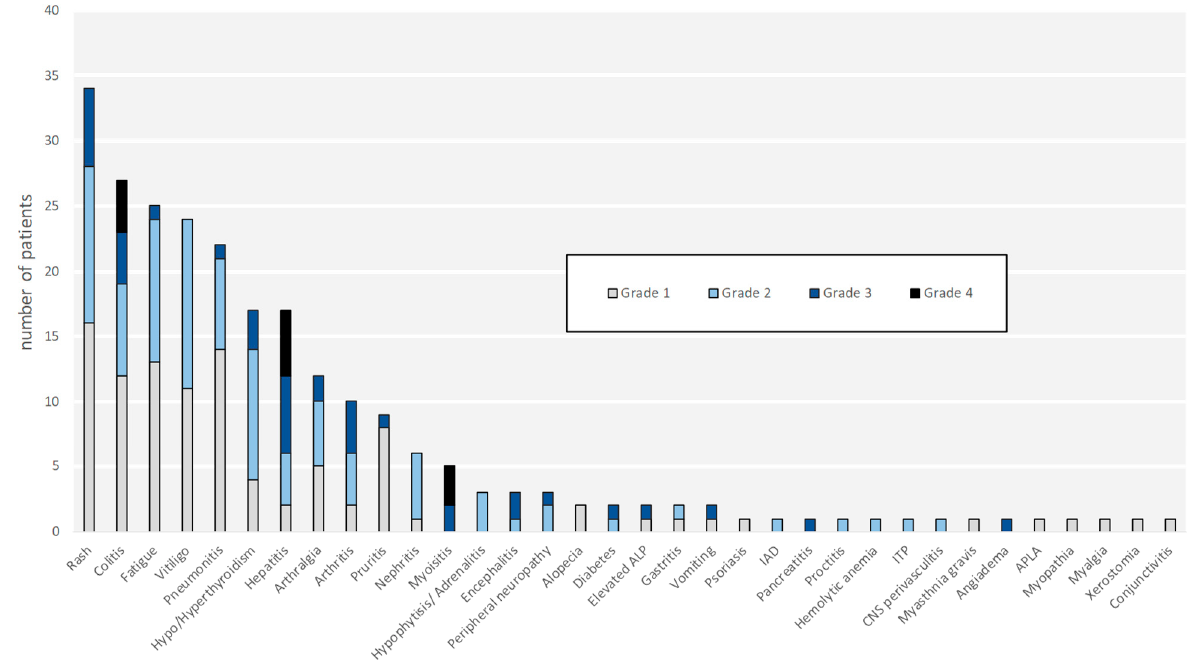
Figure 1. Grade distribution of immune-related adverse events (irAE). The most common irAE observed were cutaneous (29.9%), gastrointestinal (14.2%), rheumatologic (13.4%), endocrine (10.1%), and fatigue (9.7%). Thirty-eight patients expe- rienced high grade (grades 3–4) irAEs. The documented grade 4 irAEs were colitis, hepatitis, and myositis. Abbreviations: irAE—immune-related adverse events; ALP—alkaline phosphatase; IAD—isolated adrenocorticotropic hormone defi-